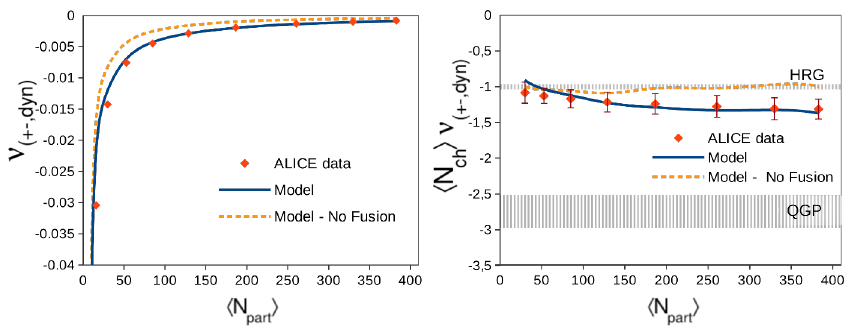
Figure 4. Dynamical charge fluctuation ν d y n as a function of centrality (number of participant nucleons) for Pb-Pb collisions at 2.76 TeV, calculated in the Monte Carlo model with string fusion and compared with experimental data [6]. The solid line corresponds to the model with string fusion, dashed – without fusion. The right panel shows ν d y n multiplied by multiplicity. Areas that correspond to hadron resonance gas (HRG) and quark-gluon plasma (QGP) are